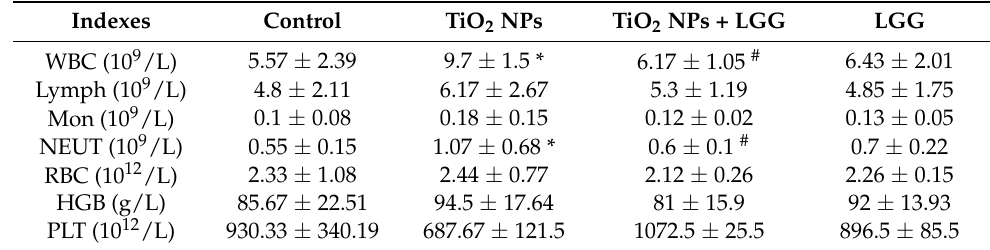
Table 2. Effects of oral exposure of TiO 2 NPs on blood routine indexes in the young rats.